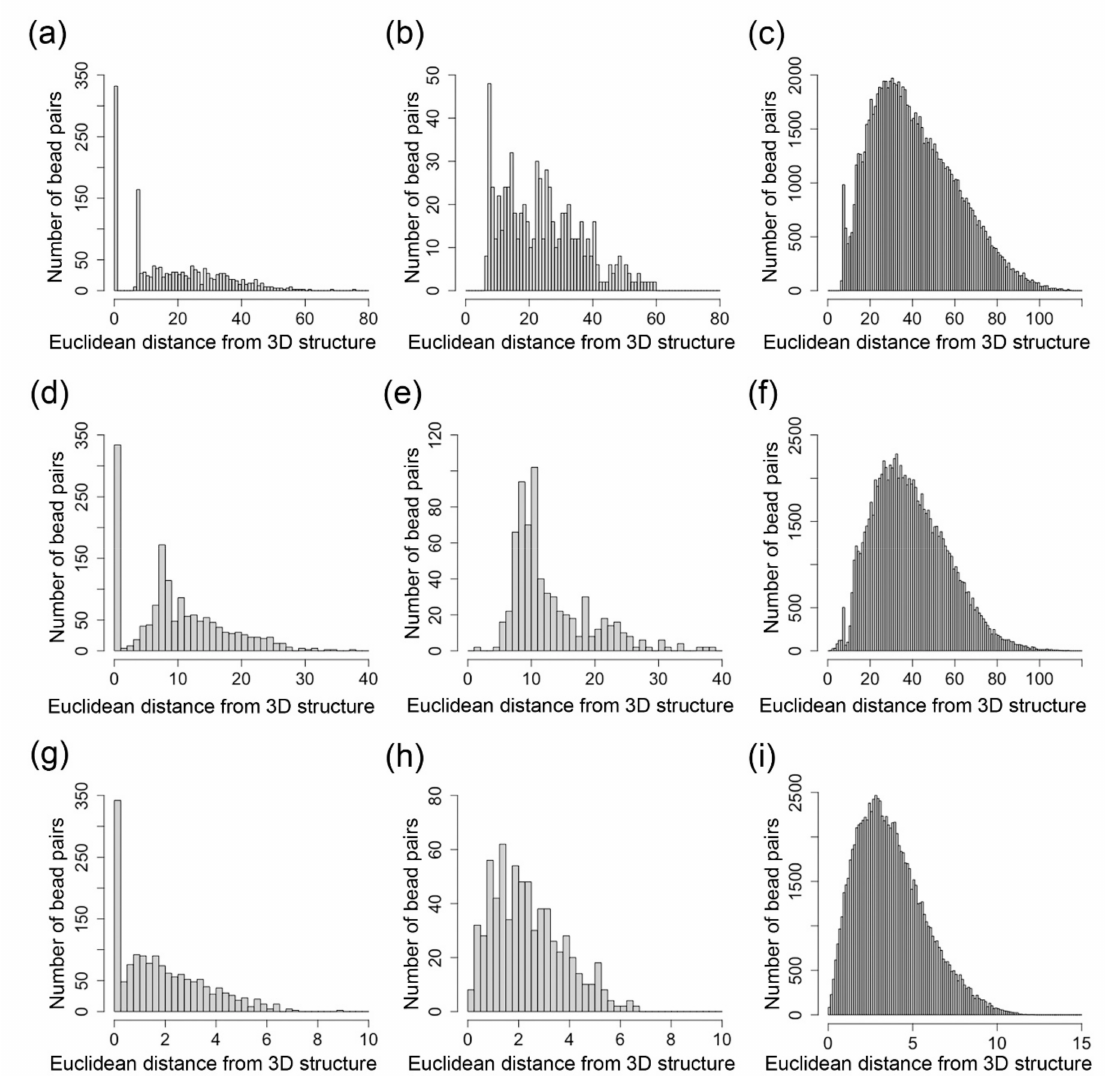
Figure 4. ( a – c ) Distributions of the number of nodes for the 3D structure inferred by our Lennard-Jones method. ( d – f ) Dis- tributions of the number of nodes for the 3D structure inferred by SCL. ( g – i ) Distributions of the number of nodes for the 3D structure inferred by nuc_dynamics. ( a , d , g ) The distribution of the number of bead pairs over different values of Euclidean distances parsed from the inferred structure when θ i,j = 1. ( b , e , h ) The distribution of the number of bead pairs over different values of Euclidean distances parsed from the inferred structure when θ i,j ∈ ( 0.7, 1 ) . ( c , f , i ) The distribution of the number of bead pairs over different values of Euclidean distances parsed from the inferred structure when θ i,j ∈ ( 0, 0.7 ]